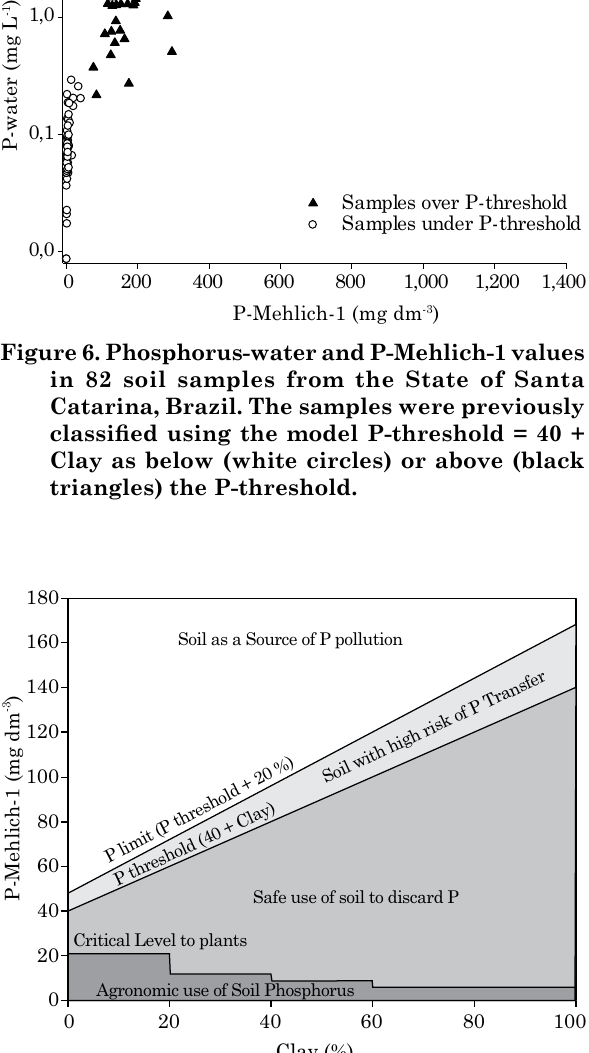
figure 5. Phosphorus levels assessed by mehlich-1 extractant at which the P-water rapidly increases upon supplementation with P (change-point) and P levels, assessed by Mehlich-1, that are 80 % of the change-point (P-threshold). P-threshold simplified is the proposed simplified model to facilitate the calculation of the P-threshold.